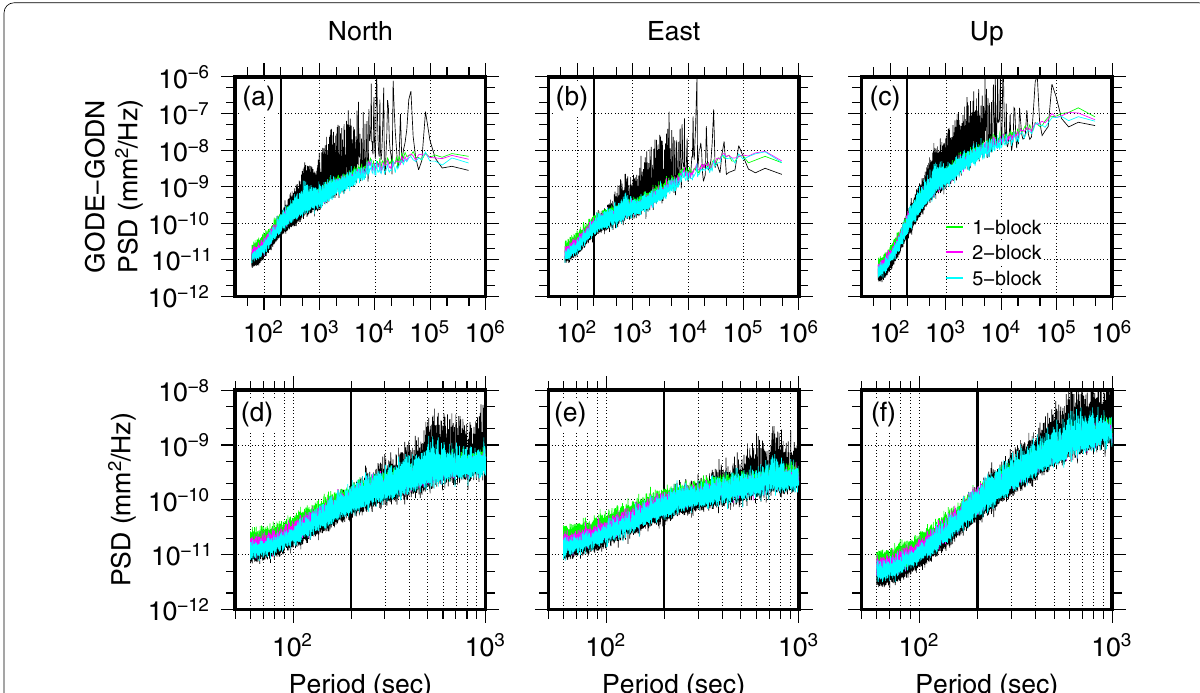
Fig. 11 Average of power spectral density (PSD) before and after sidereal filtering made by stacking. a North component. The black line indicates PSD before sidereal filtering while colored lines indicate PSD after sidereal filtering in which a sidereal filter is made by stacking one (green), two (pink), or five (light blue) blocks preceding a block of interest. Vertical thick line indicates a period of 200 s. b , c Same as a but for east and up components. d – f Same as a – c but PSDs at periods from 50 to 1000 s are magnified for